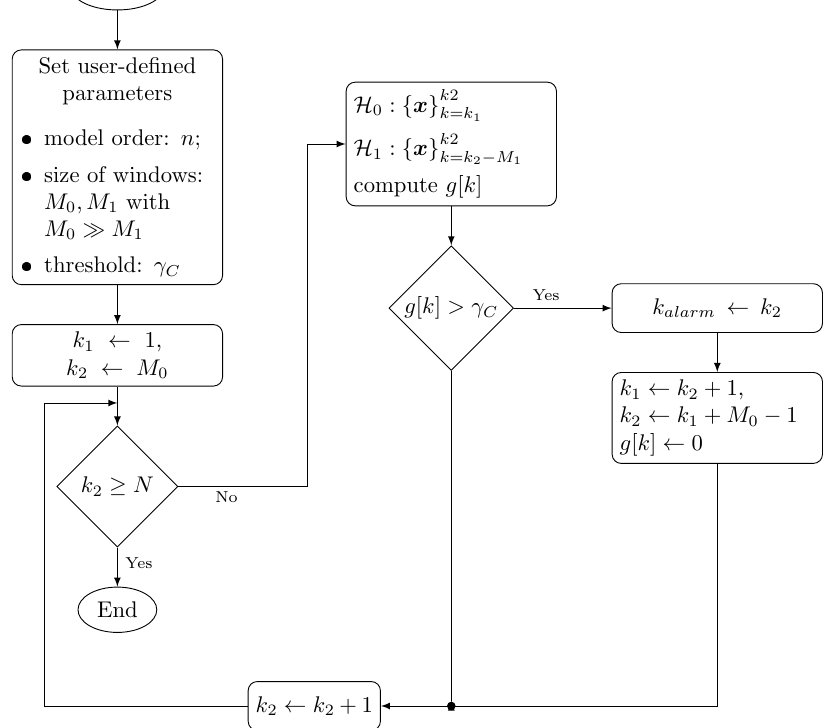
Figure 5. Flow diagram of the statistical AD method based on the CUSUM